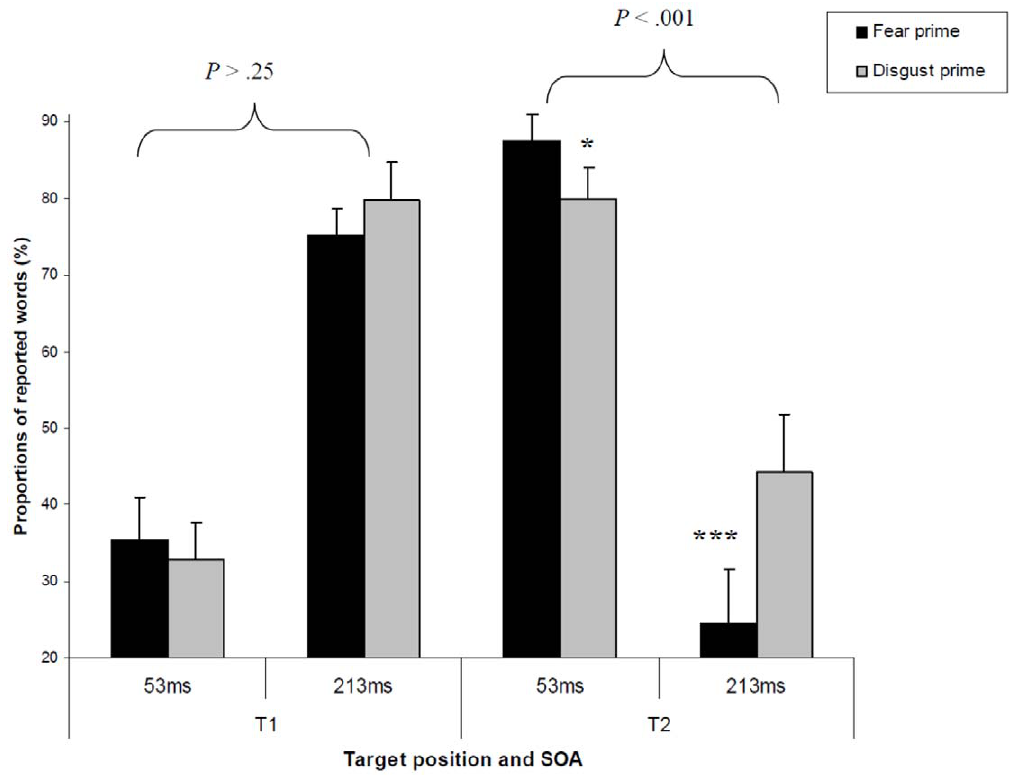
Figure 3. The influence of the emotion prime on target detection depends on the stimulus onset asynchrony (SOA), and specifically for T2 report. ThereportofT2targets(notforT1)isbetterifprecededbyadisgustfacethanbyafearface.Specificcomparisons(paired t -tests)showedthatthiseffect onT2identificationwasmainlydrivenbytheinfluenceoftheprimeatthelongerSOA(213 ms).Asignificant( t 17 = 2 4.50, P , .001)decrease( 2 19.9%)incorrect identification of targets was observed following the processing of fear primes as compared to disgust primes. Whereas at shorter SOA (53 ms), the facilitatory influence ( + 7.5%) of fear primes on identification was only marginally significant ( t 17 = 1.81, P , .09). Error bars indicate s.e.m. Note. * p , .10; *** p , .001